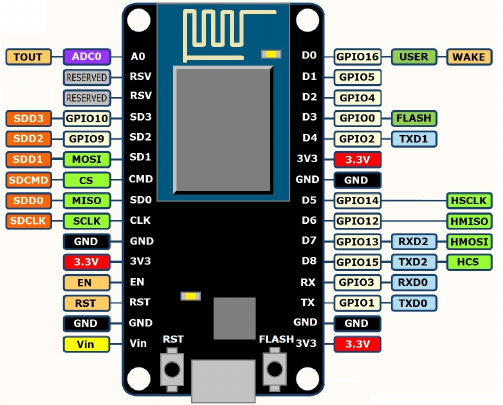
Figure 2. Pin distribution of the WiFi wireless sensor networks (WSNs) development board node micro